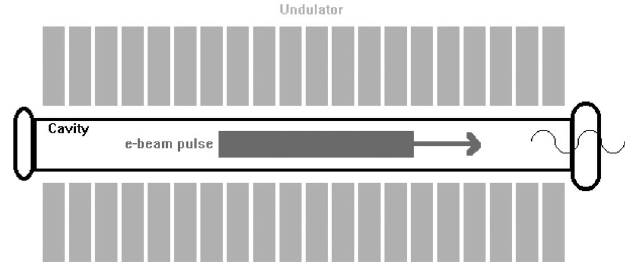
FIG. 1. Schematic illustration of a pulsed beam